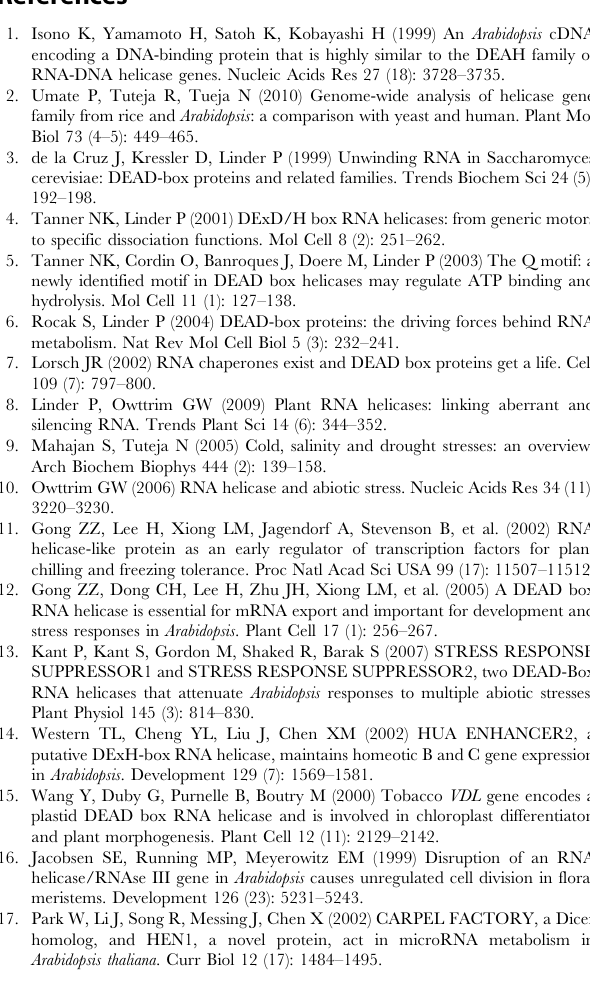
Figure S1 Phylogenetic tree analysis of RNA helicase in Arabidopsis . From left to right are the DEAD-box, DEAH-box and DExD/H-box RNA helicase proteins, respectively. The scale bar represents 0.2, 0.2 and 0.2 substitutions per sequence position, respectively. Sister pairs of paralogous helicase genes were indicated by red shadow, which had very strong bootstrap support ( . 90%). Figure S2 Phylogenetic tree analysis of RNA helicase in Oryza sativa . From left to right are the DEAD-box, DEAH-box and DExD/H-box RNA helicase proteins, respectively. The scale bar represents 0.2, 0.2 and 0.2 substitutions per sequence position, respectively. Sister pairs of paralogous helicase genes were indicated by red shadow, which had very strong bootstrap support ( . 90%). Figure S3 Phylogenetic tree analysis of RNA helicase in Zea mays . From left to right are the DEAD-box, DEAH-box and DExD/H-box RNA helicase proteins, respectively. The scale bar represents 0.2, 0.2 and 0.2 substitutions per sequence position,